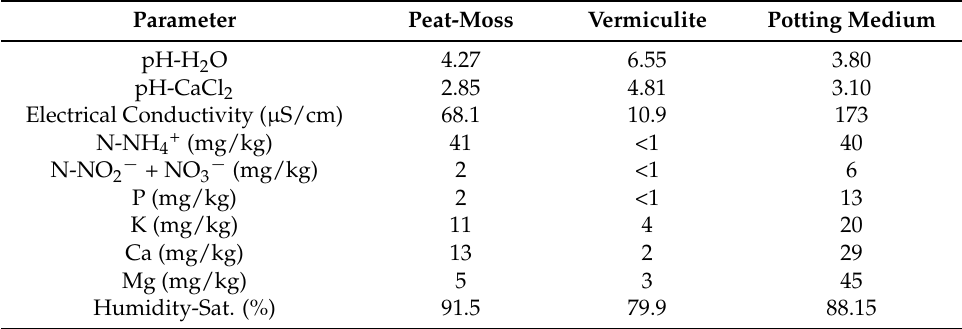
Table 1. Physicochemical parameters about selected potting medium and its components. The data were obtained under analysis at an ISO-17025 certified laboratory. They are the average of three samples of each